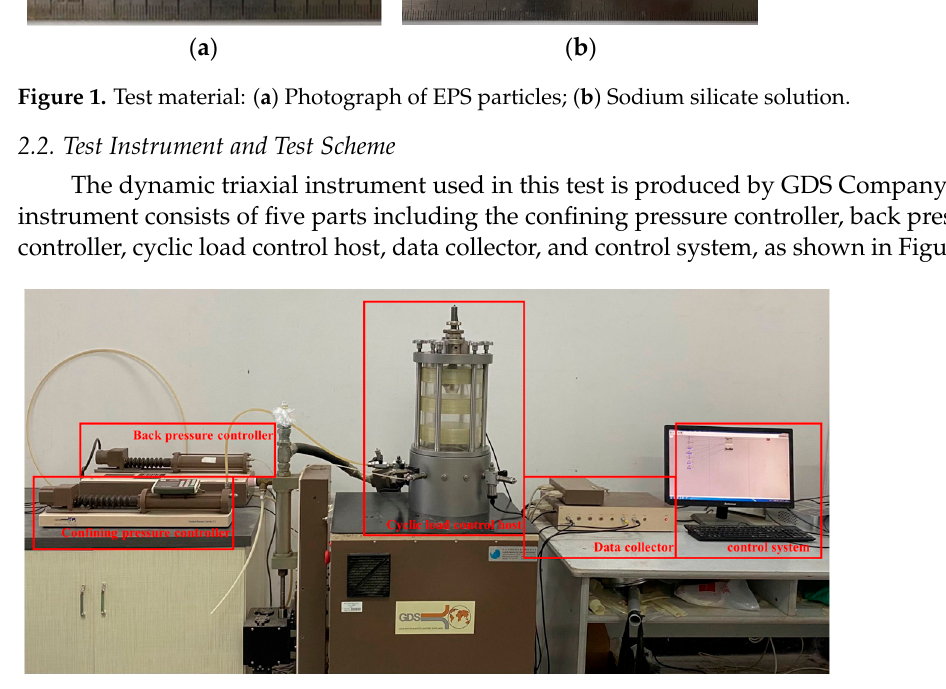
Figure 2. Dynamic triaxial test instrument.